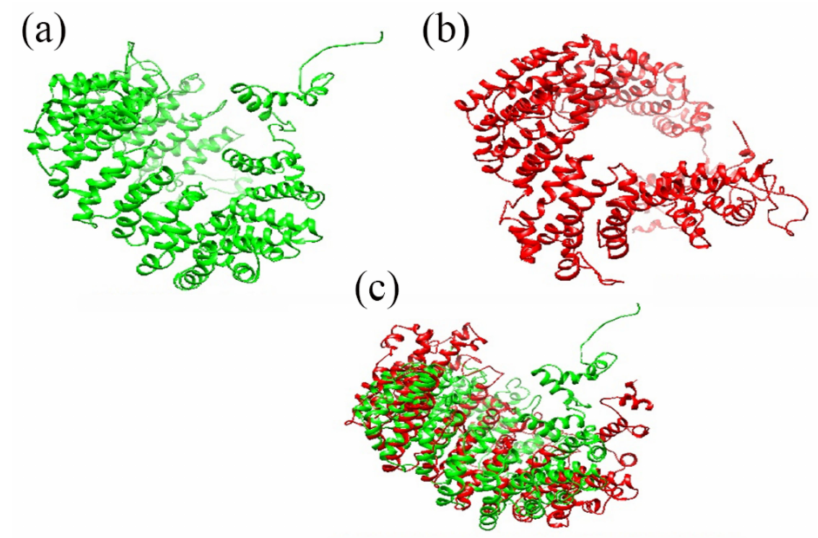
Figure 3. Superimposed 3D structures of wild-type and mutant ARMC3 proteins: ( a ) wild-type protein, ( b ) mutant protein, and ( c ) superimposed structure of wild-type and mutant